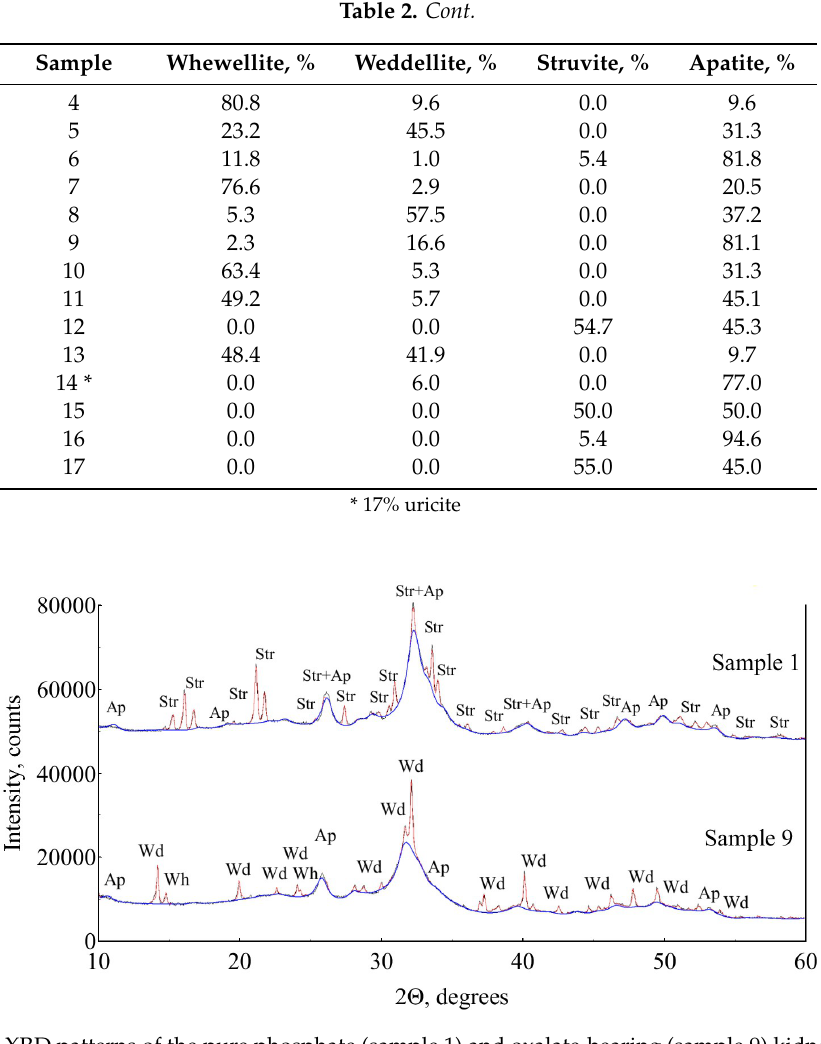
Figure 1. XRD patterns of the pure phosphate (sample 1) and oxalate-bearing (sample 9) kidney stones (red lines). The blue lines indicate the contribution of apatite in each XRD pattern (calculated by the Pawley method). Wh — whewellite, Wd — weddellite, Ap — apatite, Str — struvite. Unit cell parameters of apatite from the studied urinary stones (Table 3) vary in the wide range of 9.365(2)–9.437(3) Å for a and 6.854(2)–6.882(2) Å for c . Table 3. Unit cell parameters of apatite from the studied urinary stones *.